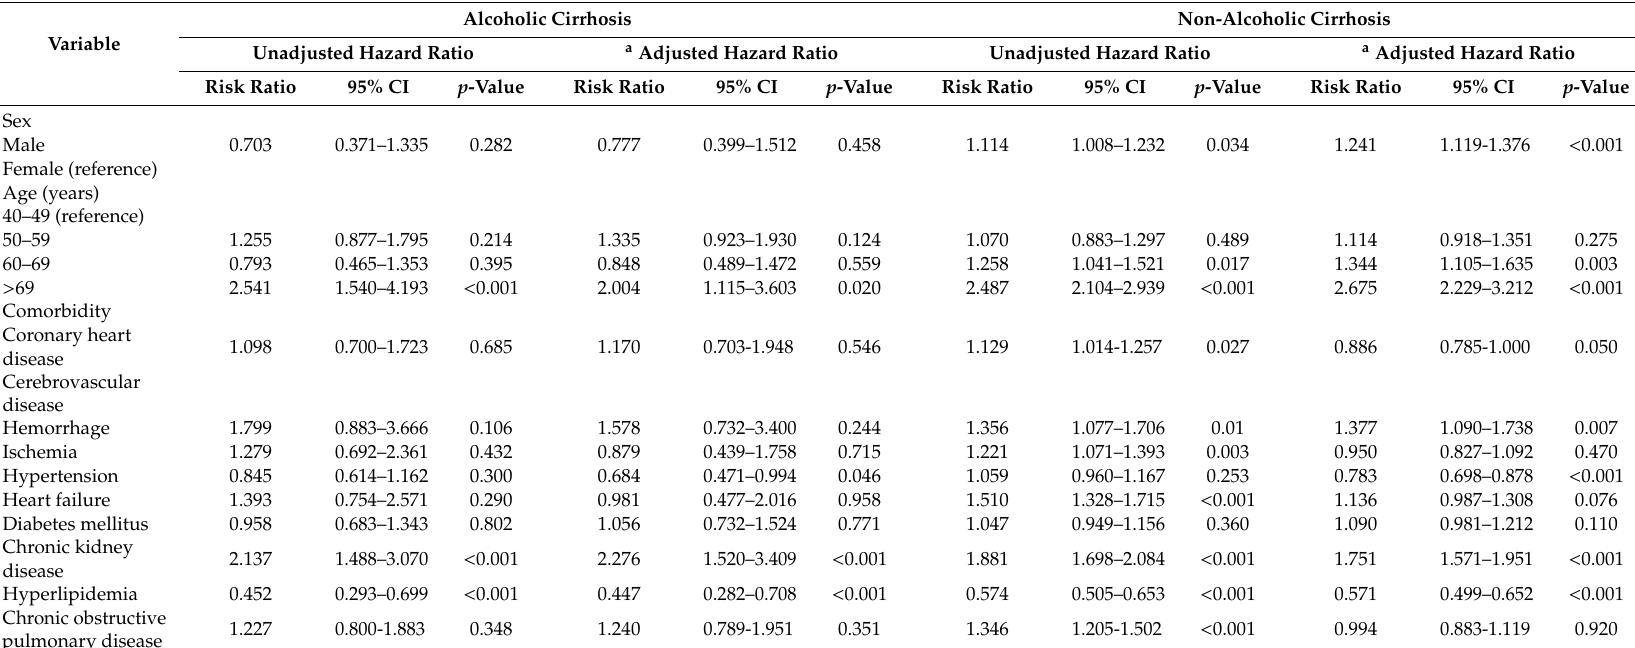
Table 2. Multivariable Cox proportional hazards model for comorbidities and survival